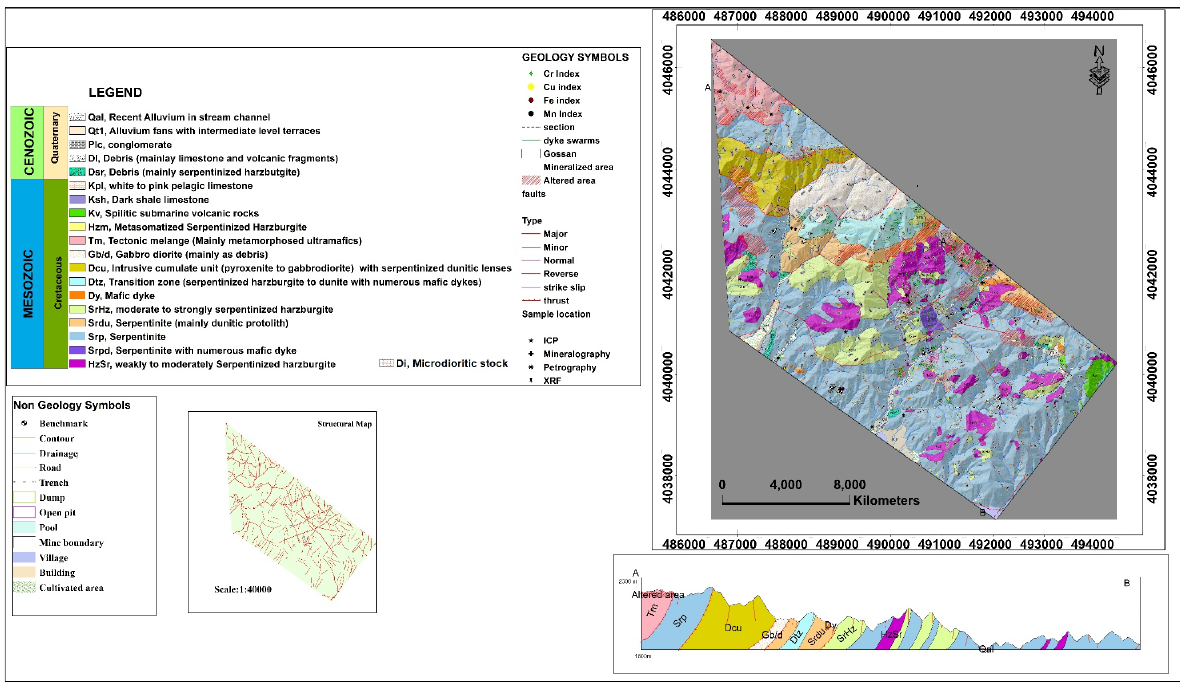
Figure 12. The final geological map of the study area, the inset image is the structural map of the area. Due to the highly heterogenous mineralogy and rock name, all dykes are shown on the geological map, with a single attributed “mafic dyke” name.